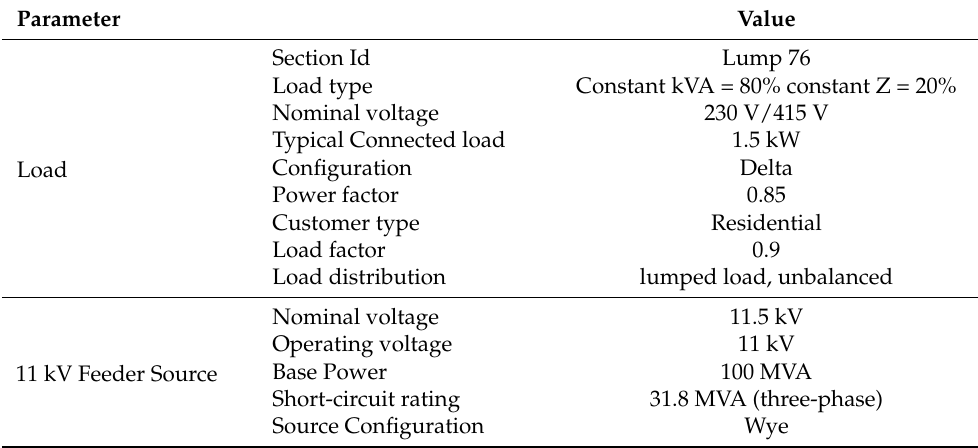
Table 1. Data of a typical residential customer and an 11 kV source representing the primary substation used in the simulation.